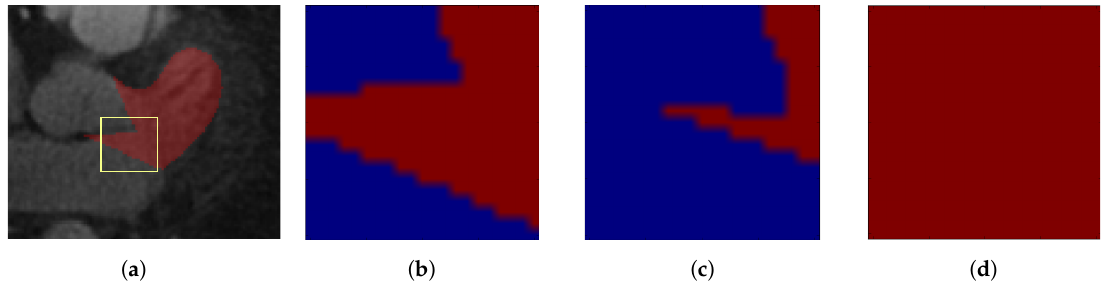
Figure 12. ( a ) the overlaid ground truth shown in red and the smart brush patch shown with a yellow rectangle; ( b ) the extracted patch from the smart brush; ( c ) the pre-segmented mask that is obtained by eroding the extracted patch; ( d ) the segmentation result by using the smart brush, which is different to the ground truth patch due to the same intensity rage